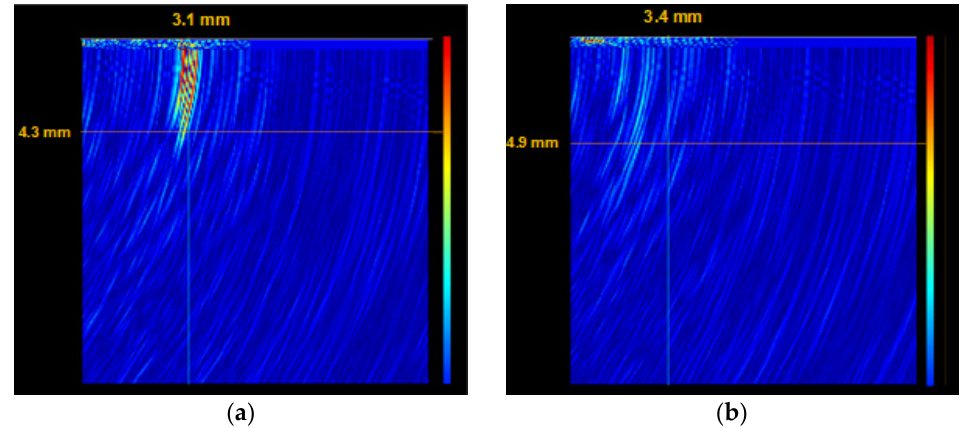
Figure 9. View of the cross-section of selected microcracks of the brake disc section obtained with the GEKON ultrasonic flaw detector: ( a ) crack with a depth of 4.3 mm and ( b ) crack with a depth of 4.9 mm.